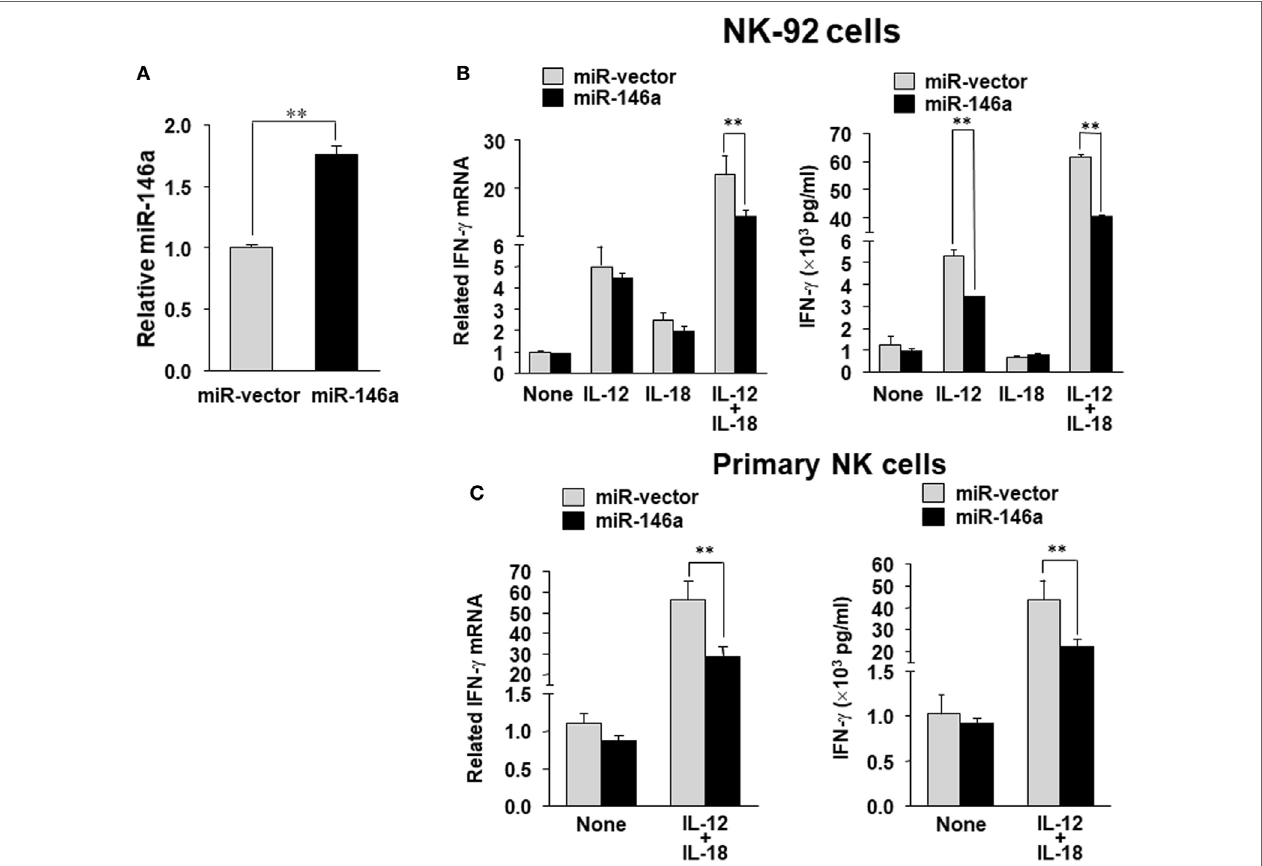
FigUre 1 | miR-146a overexpression decreases IL-12 plus IL-18–induced IFN- γ production in NK cells. NK-92 cells were infected with the lentivirus containing GFP (miR-vector) or GFP and miR-146a. Cells were then sorted for high GFP expression and analyzed for miR-146a expression (a) . NK-92 cells (B) or primary human CD56 + NK cells (c) were infected using either miR-vector or miR-146a, sorted by FACS for GFP, and co-stimulated with IL-12 (10 ng/mL) plus IL-18 (100 ng/mL) for 24 h. Cell pellets were collected for RNA preparation and cDNA synthesis, followed by assessment of IFN- γ gene expression by quantitative (q) RT-PCR. Supernatants were collected to measure IFN- γ protein levels by enzyme-linked immunosorbent assay (ELISA). The data shown are representative of at least four experiments with similar results. Data are reported as mean ± SD. * p < 0.05; ** p < 0.01. Error bars represent